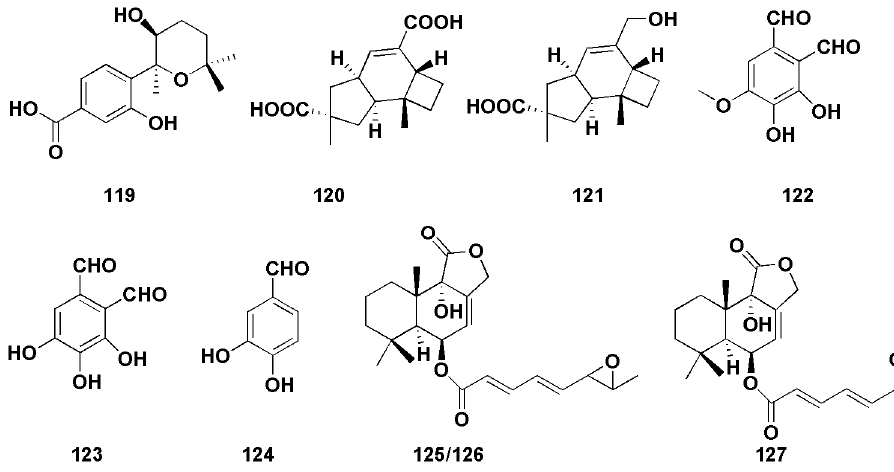
Figure 9. Chemical structures of other biological compounds ( 119 – 127